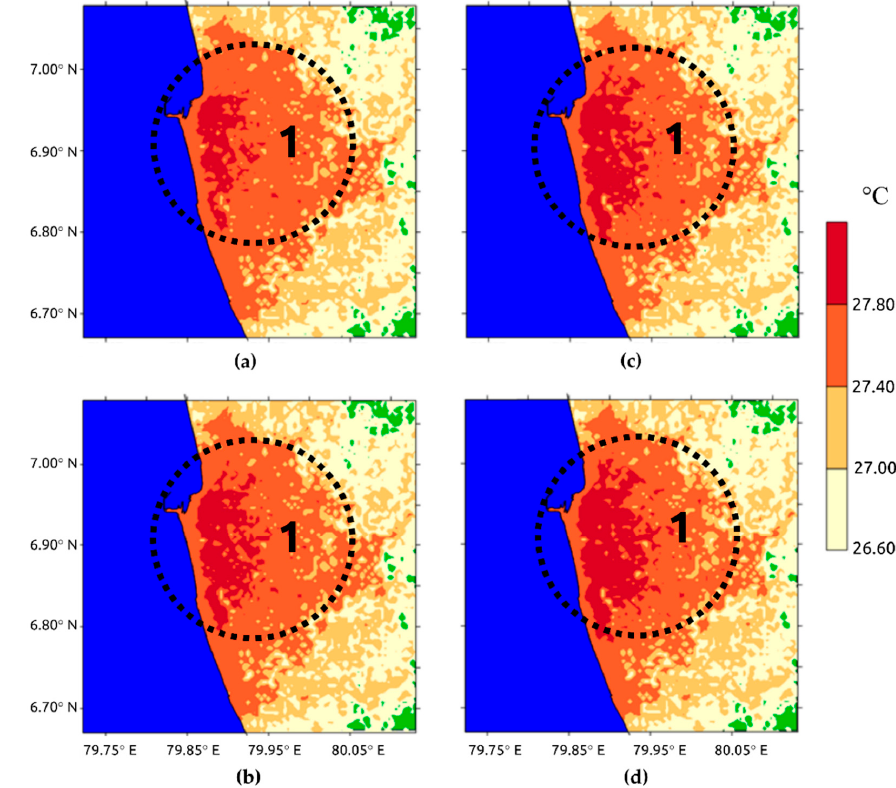
Figure 8. ( a ) Average temperature distribution due to land-use change in 2015; ( b ) Providing only 10% Figure 8. (a) Average temperature distribution due to land-use change in 2015; (b) Providing only greening; ( c ) Providing by 5%; ( d ) No green 10% greening; (c) Providing by 5%; (d) No green areas.